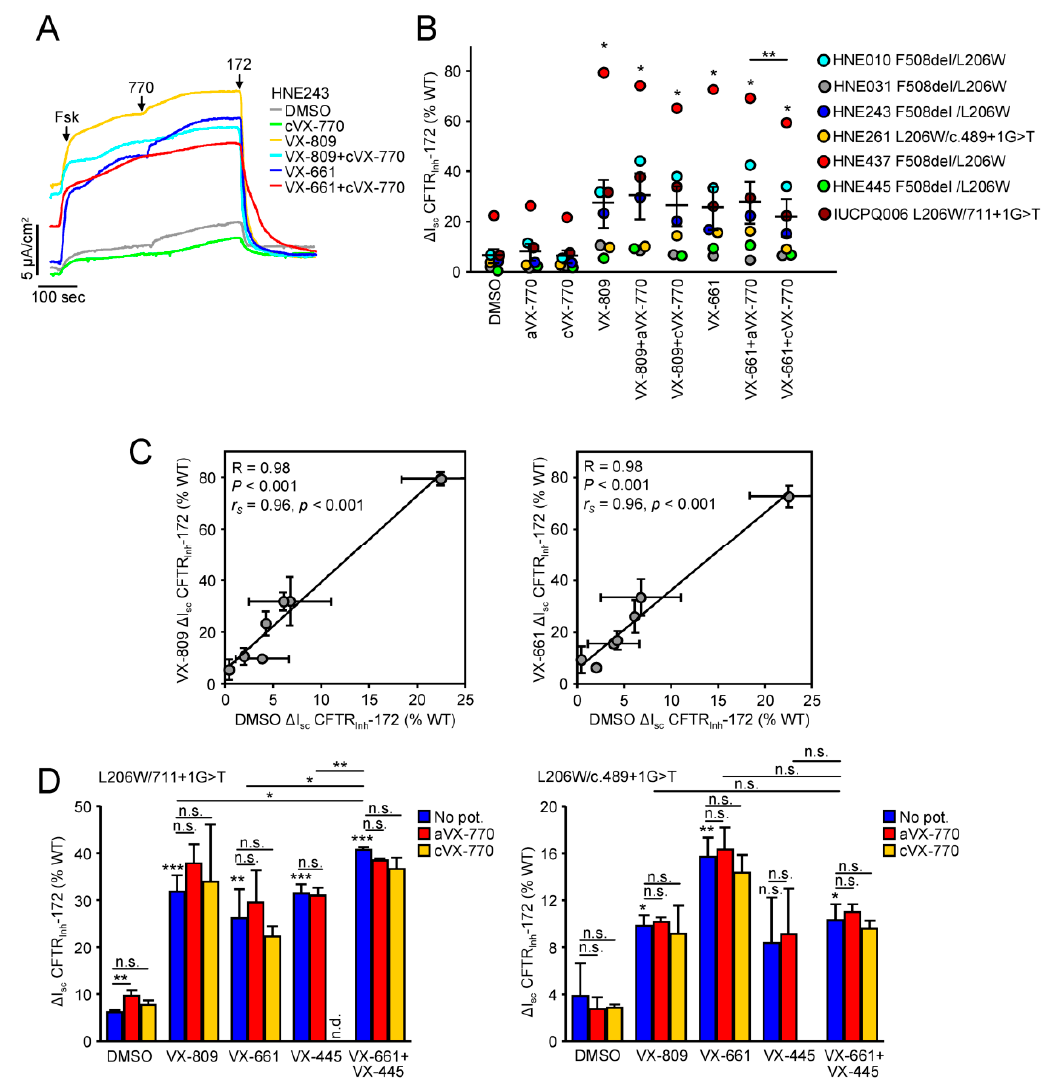
Figure 4. Efficacy of CFTR modulators for the functional correction of L206W-CFTR in HNE. ( A , B ) Effect of indicated single correctors (VX-809, VX-661-3 µ M, 24 h) alone or in combination with acute VX-770 (aVX-770) or chronic VX-770 (cVX-770-1 µ M, 24 h) potentiation on the I sc of HNE from 7 patients with one L206W-CFTR allele. Representative traces ( A ) and quantification of the CFTR Inh -172 inhibited current expressed as percentage of WT-CFTR currents in HNE from 10 donors ( B ). CFTR-mediated currents were induced by sequential acute addition of forskolin (Fsk, 20 µ M) and VX-770 (10 µ M, aVX-770) followed by CFTR inhibition with CFTR Inh -172 (Inh-172, 20 µ M) in an intact monolayer with basolateral-to-apical chloride gradient. Black lines in B indicate mean ± SEM. ( C ) Correlation between the basal Fsk-stimulated current and the Fsk-stimulated current in VX-809 (left panel) or VX-661 corrected (right panel) HNE. R, P -Pearson correlation coefficient and associated p -value; r S , p -Spearman’s rank correlation coefficient and associated p -value. ( D ) Effect of indicated single correctors or corrector combinations (VX-809, VX-661-3 µ M; VX-445-2 µ M; 24 h) alone (no pot.) or in combination with acute VX-770 (aVX-770) or chronic VX-770 (cVX-770-1 µ M, 24 h) potentiation on the I sc of HNE from 2 patients with one L206W-CFTR allele and a splice site mutation on the second allele. Data in C and D are means ± SD of 3 measurements. n.s.—not significant, * p < 0.05, ** p < 0.01, *** p < 0.001 by Student’s t -test. A large inter-donor variation in the forskolin stimulated I sc in compound heterozy- gous L206W-CFTR HNE was observed both before and after correction with VX-809 or VX-661, similar as noted for homozygous Δ F508-CFTR HNE [19]. Concordantly, after expressing the corrected I sc as percentage of the basal channel activity lower variance between HNE from individual patients was observed (Supplementary Figure S2A). These observations led us to investigate whether the basal channel activity is correlated to the level of correction in individual HNE. Both parametric (Pearson correlation coeffi- cient) and non-parametric (Spearman’s rank correlation coefficient) correlation analysis